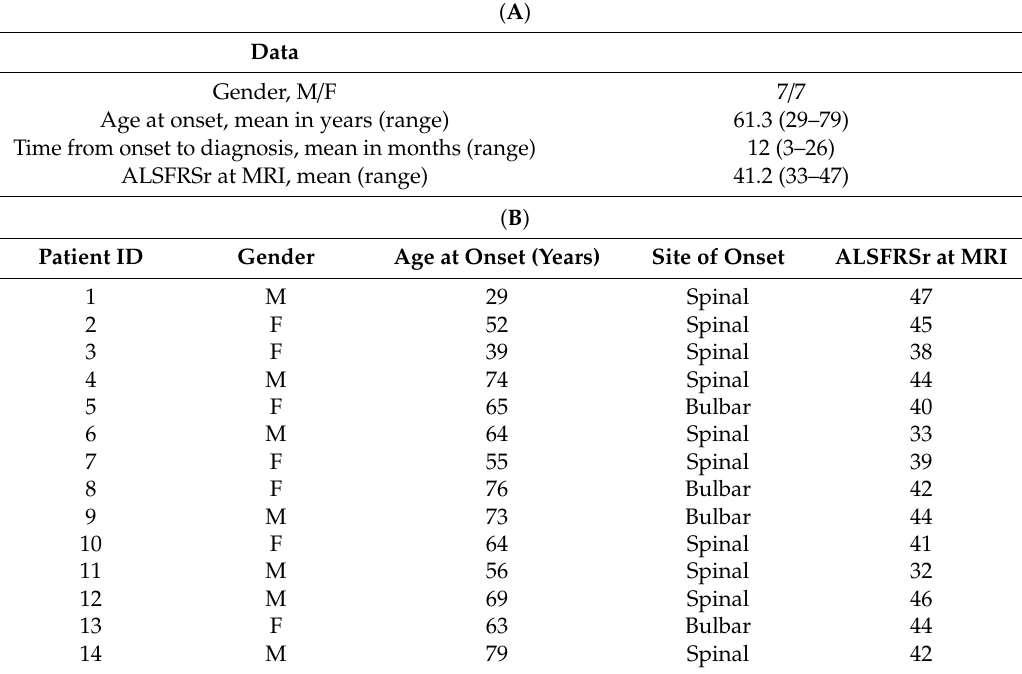
Table 1. Clinical and demographic data of Amyotrophic Lateral Sclerosis (ALS) patients ( A ) summary and ( B ) for each